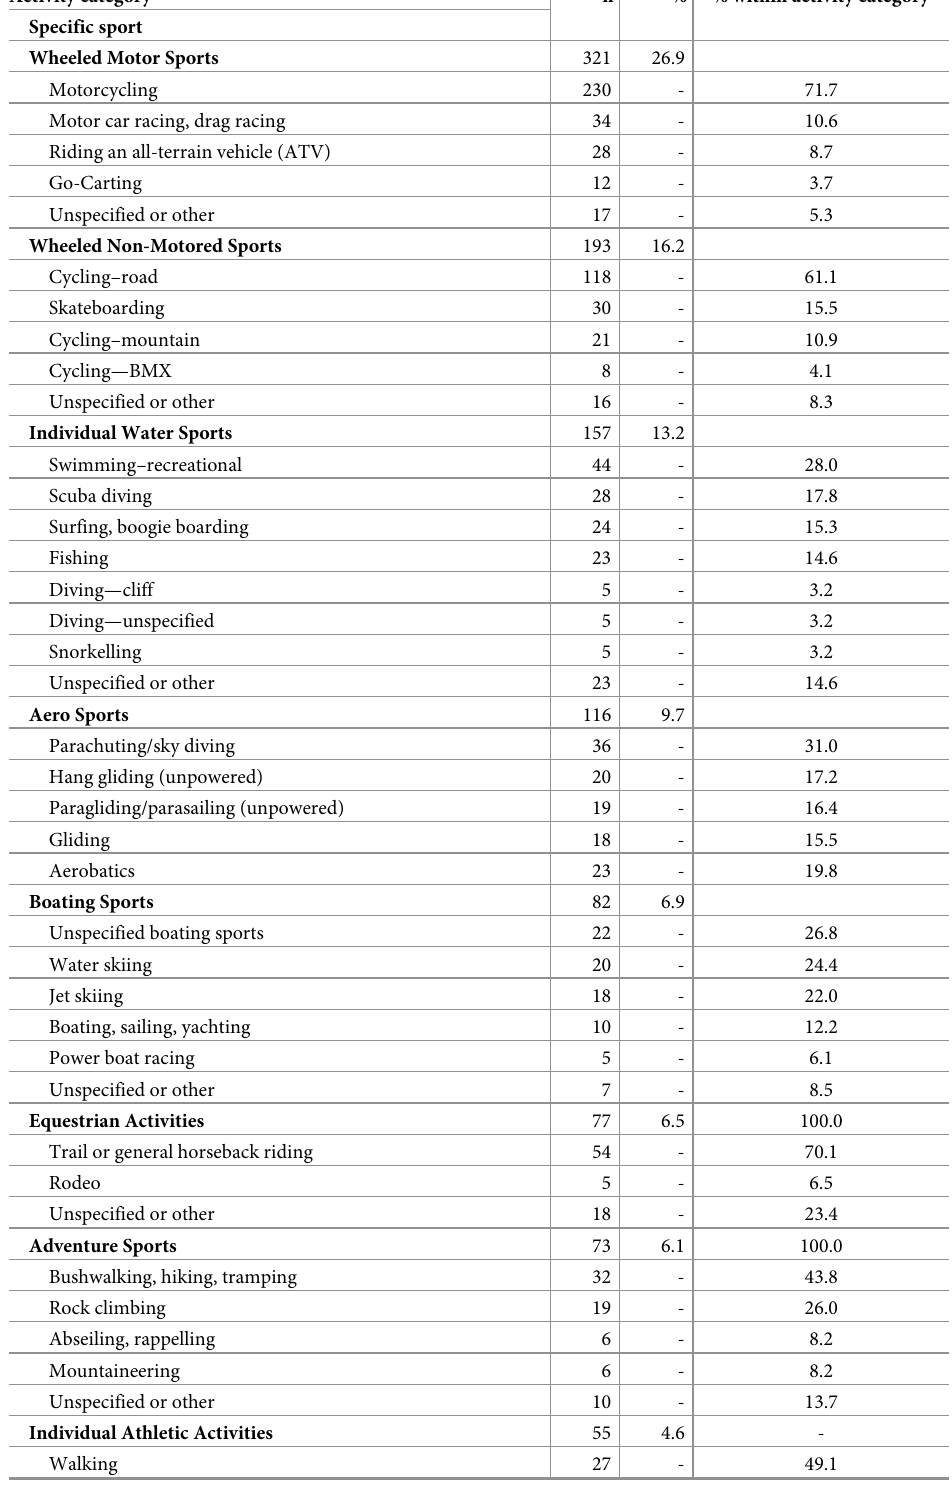
Table 2. Number of injury deaths by different types of sport and exercise during leisure time (n =